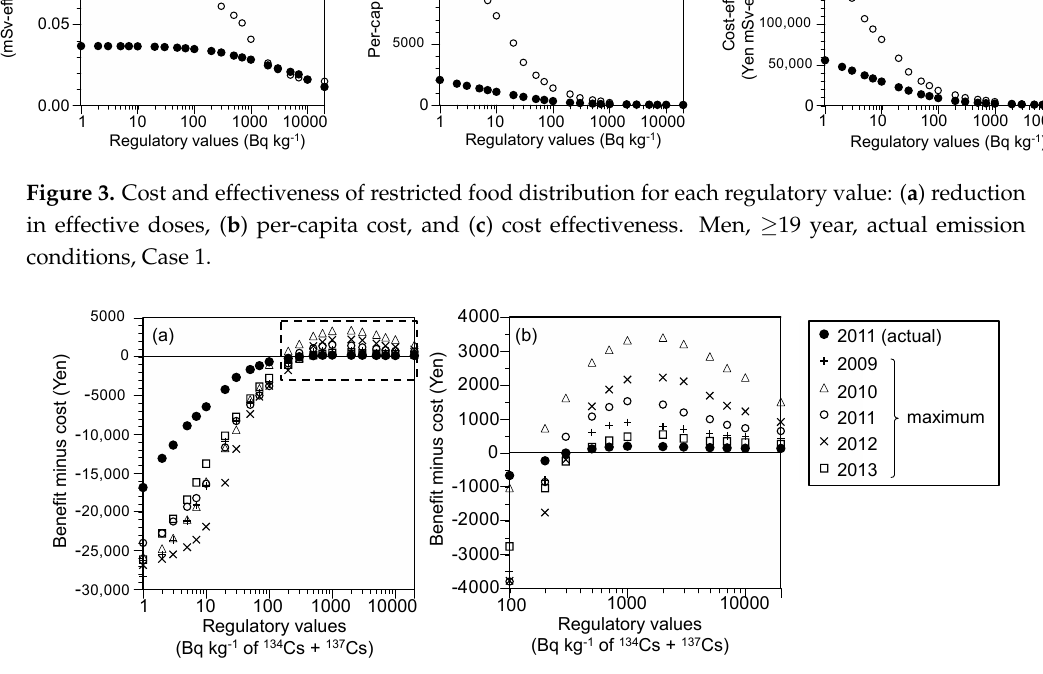
Figure 4. Net values of restricted food distribution for each regulatory value for radiocesium: ( a ) 1– 20,000 Bq kg − 1 and ( b ) 100–20,000 Bq kg − 1 .